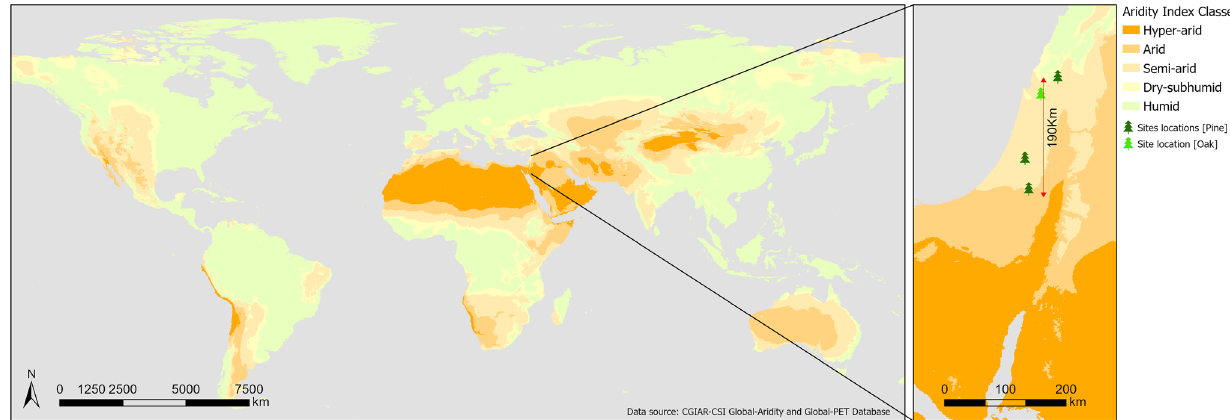
Fig. 1 Global aridity index map and location of study sites across the climatic gradient in Israel. The Aridity Index is calculated as the ratio between Mean Annual Precipitation and Mean Annual Potential Evapotranspiration (Data source: Global AI v2 http://www.cgiar-csi.org). AI was then used to classify hyper-arid (AI < 0.05), arid (0.05 < AI < 0.2), semi-arid (0.2 < AI < 0.5), dry-subhumid (0.5 < AI < 0.65), and humid (AI > 0.65) areas. The enlarged inset map shows the climatic gradient in Israel, indicating the paired site ’ s locations of forested (pine or oak) and adjacent non-forested ecosystems. AI classes are presented with the color palette from orange (hyper-arid) to green